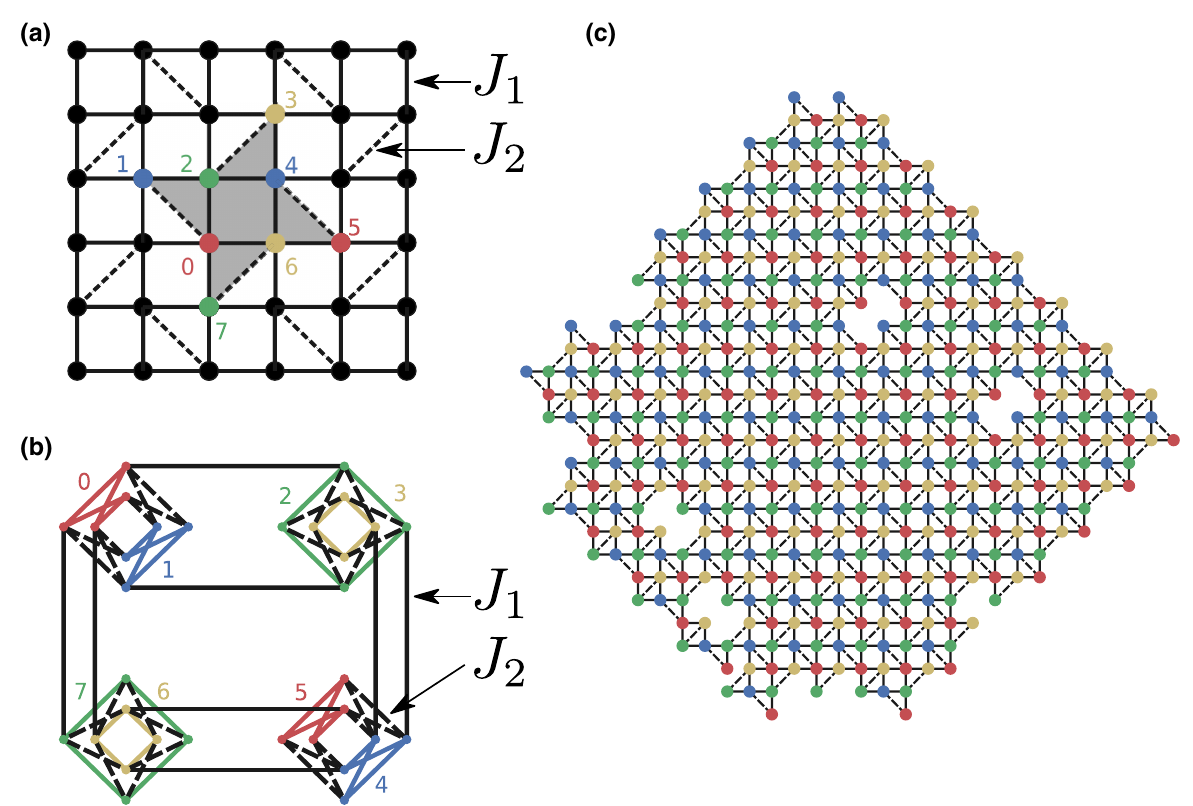
FIG. 1. Embedding the Shastry-Sutherland lattice in the D-Wave quantum annealer. (a) The Shastry-Sutherland lattice showing the nearest-neighbor square (solid black lines) and the next-nearest-neighbor dimer (dashed black lines) interactions. Highlighted in gray is the logical unit cell with eight spins labeled. (b) The embedding of the logical unit cell from (a) into a Chimera graph (full embedded graph shown in Fig. 5). This “half-cell” embedding maps each logical spin to a chain of four ferromagnetically connected qubits (solid color lines) and each dimer pair to a single Chimera unit cell. Each logical square bond is mapped to one external coupler (solid black lines) between Chimera unit cells and each dimer bond is mapped to eight internal couplers (dashed black lines) within a Chimera unit cell. This embedding preserves the symmetry of the logical problem and ensures that every physical qubit experiences similar local environments, which prevents chain breaking. (c) The embedding of a 468-spin lattice in the quantum annealer. Missing lattice sites in the underlying Chimera graph reveal defects that originate from defective qubits or bonds in the annealer. Effects from these defects, as well as from finite boundaries, are mitigated by applying self-consistent mean-field boundary conditions (see the text). These boundary conditions are applied on both the external boundaries and the internal boundaries (qubits surrounding defects)